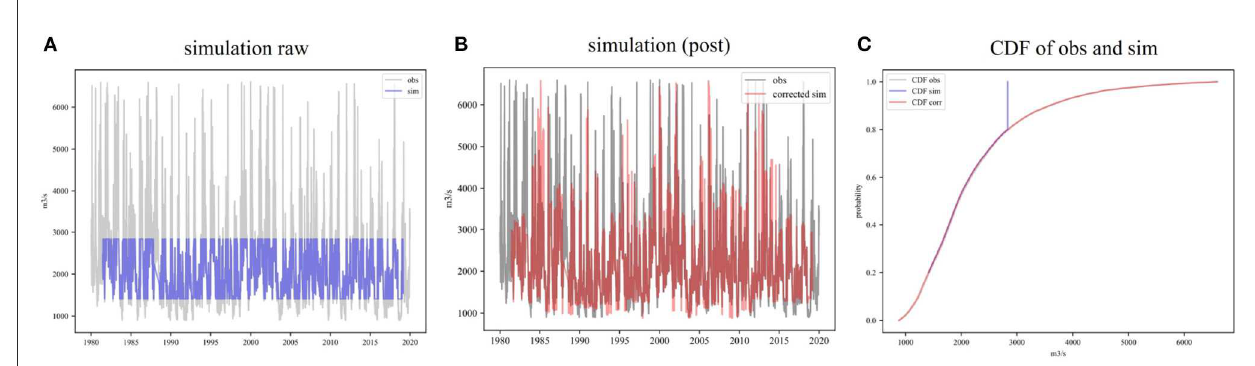
FIGURE2 Example station Lobith (MReg model) including the (A) discharge observations (gray) and the simulated discharge (withholding 20 th and 80 th percentile in training, blue), (B) post-processed discharge simulation (red) and (C) discharge CDF including observations (obs) and simulations (sim), both raw and